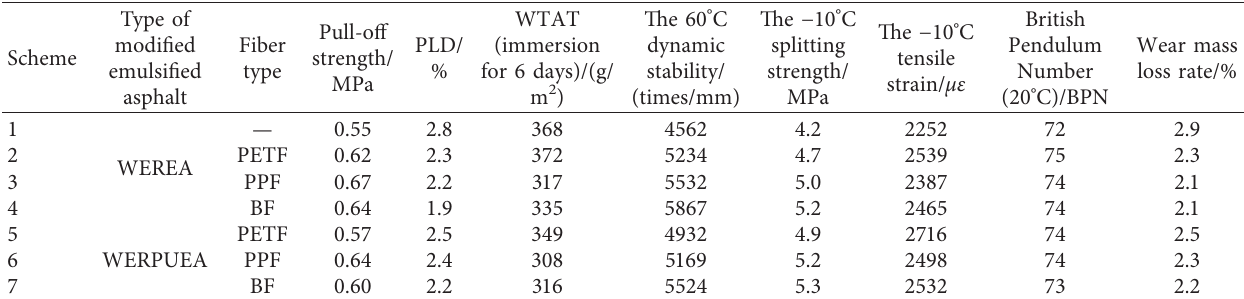
Figure 11: British Pendulum Number and wear mass loss rate of the microsurfacing. Table 6: Road performance of polymer modified emulsified asphalt fiber